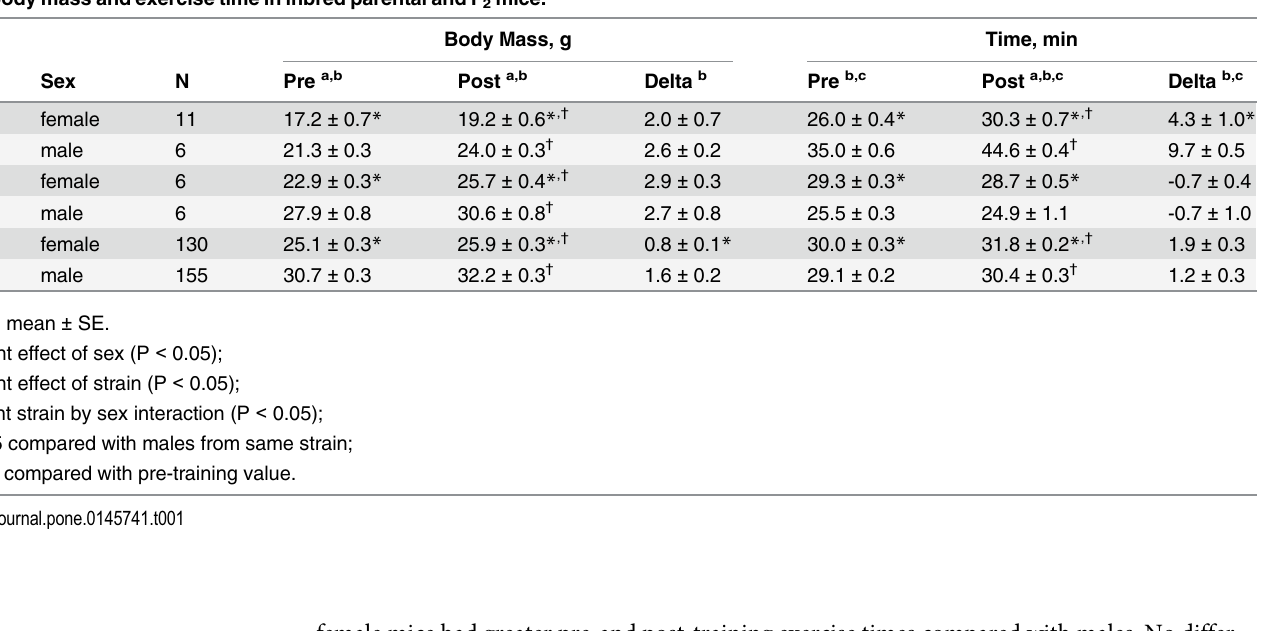
female mice had greater pre-and post-training exercise times compared with males. No differ- ence between males and females was observed for the response to training.